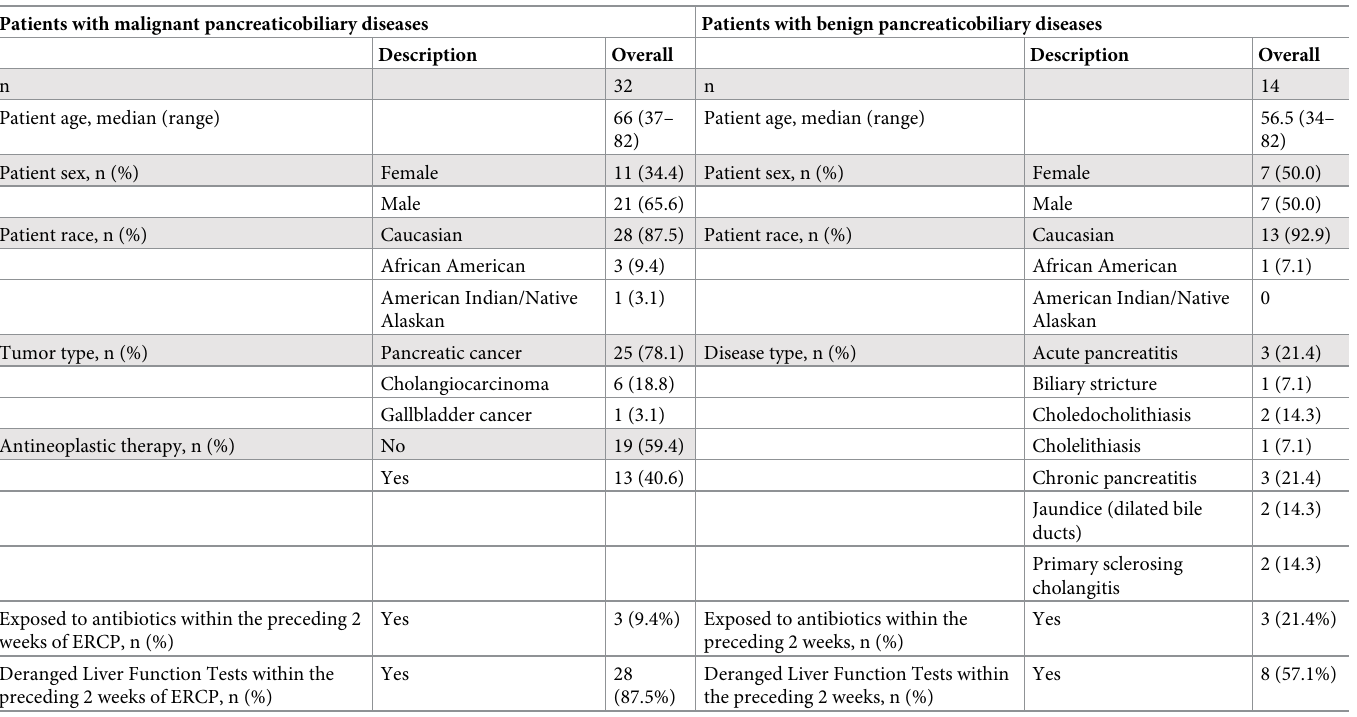
Table 1. Overall characteristics of all patients.